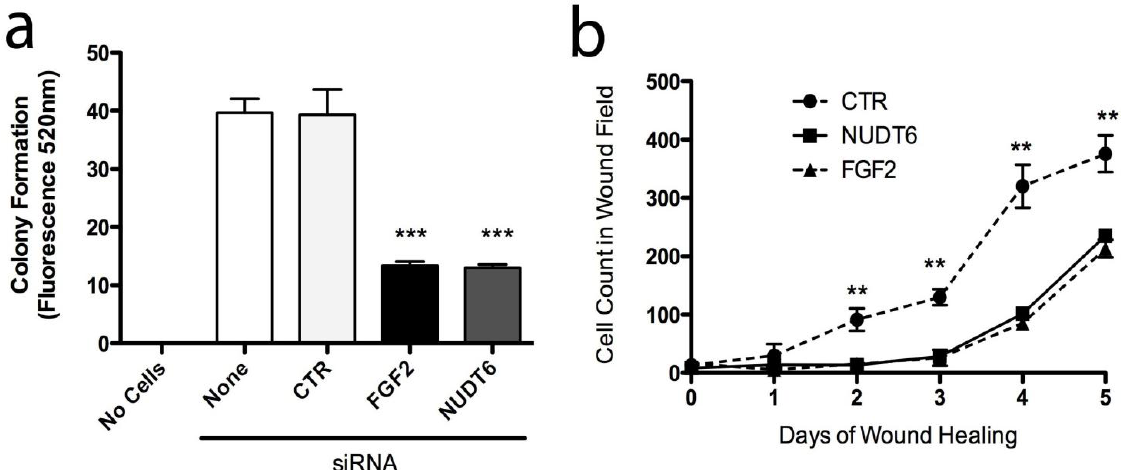
Figure 8. Knockdown of FGF2 or NUDT6 inhibits anchorage-independent growth and wound healing. ( a ) Both FGF2 and NUDT6 siRNA (100 nM) significantly reduced colony formation in soft agar ( *** p < 0.001 vs . transfection with negative control siRNA); ( b ) Inhibition of wound healing activity following siRNA knockdown of FGF2 or NUDT6 ( ** p < 0.01 vs . FGF2 or NUDT6 siRNA